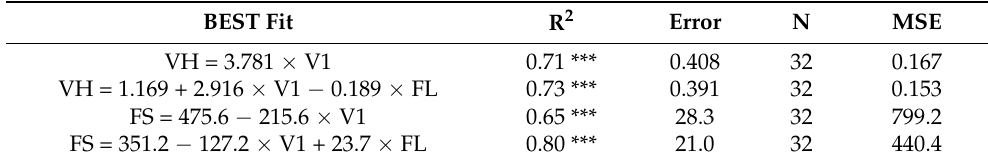
Table 6. Best fits of the relationships between dry weight and volume at Period 1 vs. at harvest in Manzanilla experiments (Figure